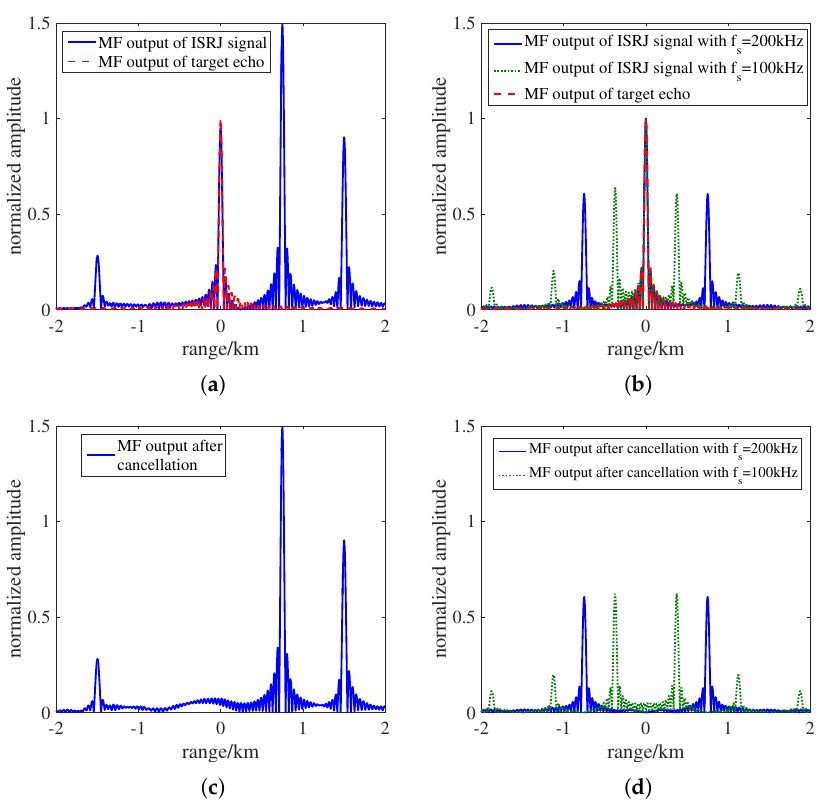
Figure 4. Target echo cancellation result with amplitude match. ( a ) matched filtering (MF) output of the interrupted-sampling repeater jamming (ISRJ) signal and target echo of Method 1. ( b ) MF output of the ISRJ signal and target echo of Method 2. ( c ) MF output after echo cancellation of Method 1. ( d ) MF output after echo cancellation of Method